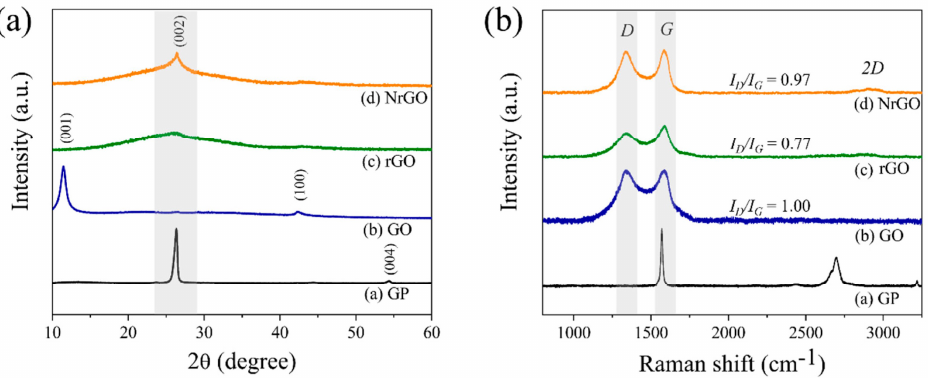
Figure 1. ( a ) XRD patterns and ( b ) Raman spectra of prepared modified graphene; GP, GO, rGO, and